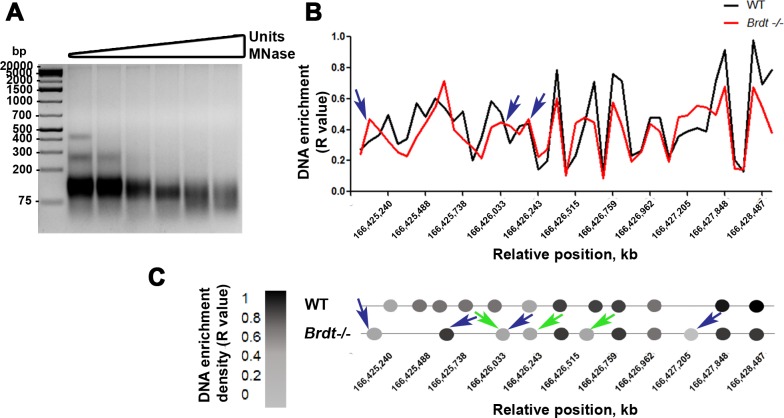
Chromatin organization at the CO hotspot of the PAR changes in the absence of BRDT.(A) Concentration-course of chromatin digestion from testicular cells with a 6 point MNase titration (0.125U/ul, 0.25U/ul, 0.5U/ul, 1U/ul, 2U/ul, 3U/ul). Samples were obtained from four WT mice per experiment. Three experiments total. (B) DNA enrichment density map of the region 166,425 to 166,446 kb of the X chromosome, obtained by tiled qPCR after MNase digestion of pachytene spermatocytes. Triplicates per each reaction were used in each genotype (four WT and Brdt-/- mice per experiment). (C) Graphic representation of the DNA enrichment position and density levels based on the graph displayed in (B) The color code represents the level of DNA enrichment based on the R value shown in (B). Blue arrows indicate protein occupancy areas present in Brdt-/- chromatin that are not observed in WT chromatin. Green arrows indicate lower protein occupancy areas in Brdt-/- chromatin.